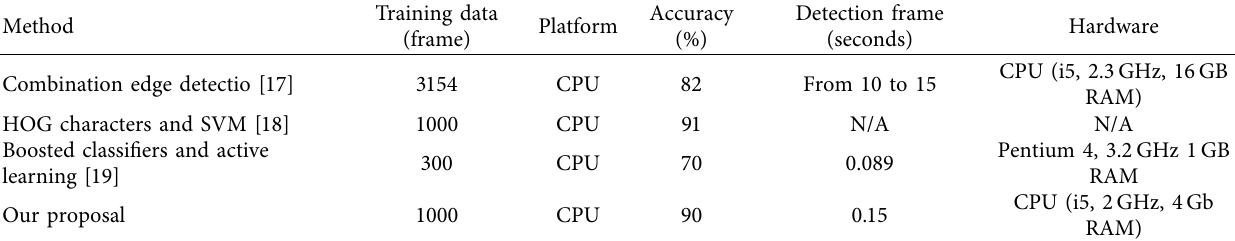
Table 6: Results of comparison with other hand gesture detection